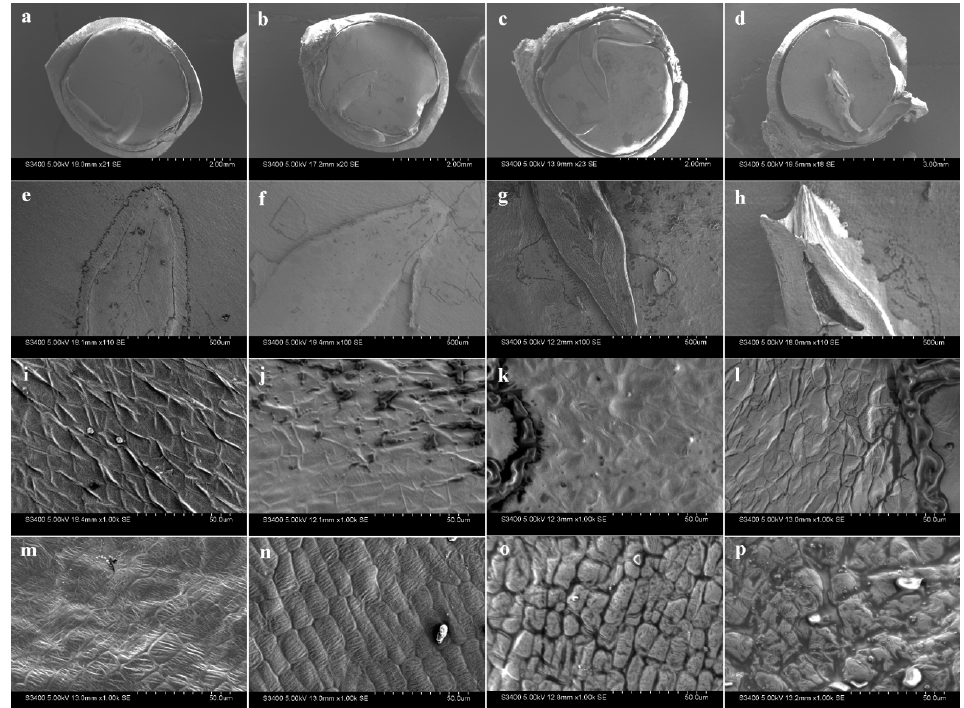
Figure 4. Longitudinal section of intact dry (DS), imbibed (BS), cracked (CS), and germinated (GS) seeds of Chinese pistache ( a – d ); plumule of DS, BS, CS, and GS ( e – h ); inner cotyledon of DS, BS, CS, and GS ( i – l ); and outer cotyledon of DS, BS, CS, and GS ( m – p ) under a scanning electron microscope.